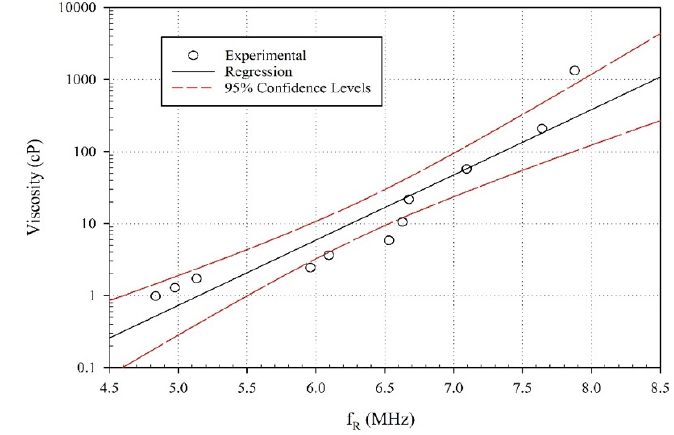
Figure 6. Frequency vs viscosity regression.